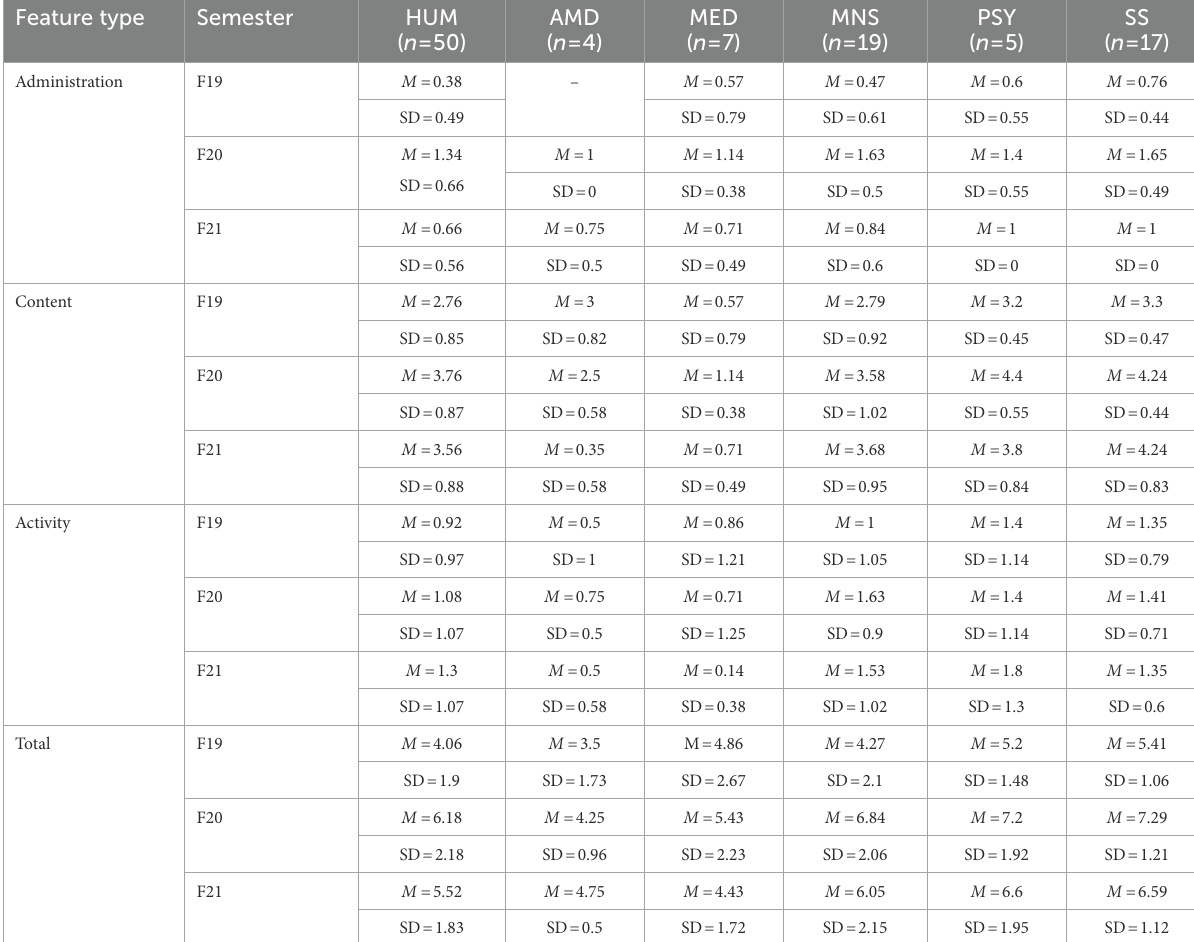
TABLE 8 Descriptive statistics of feature types by semester and